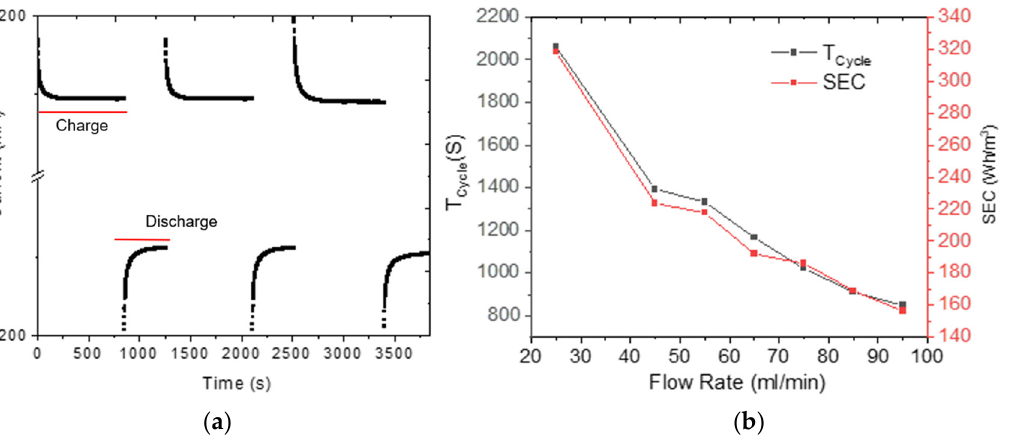
Figure 9. ( a ) A typical current variation of absorption-desorption cycles of the CDI (0.2 M, 1.2 V, 70 mL/min). ( b ) T Cyle an SEC variation as function of flow